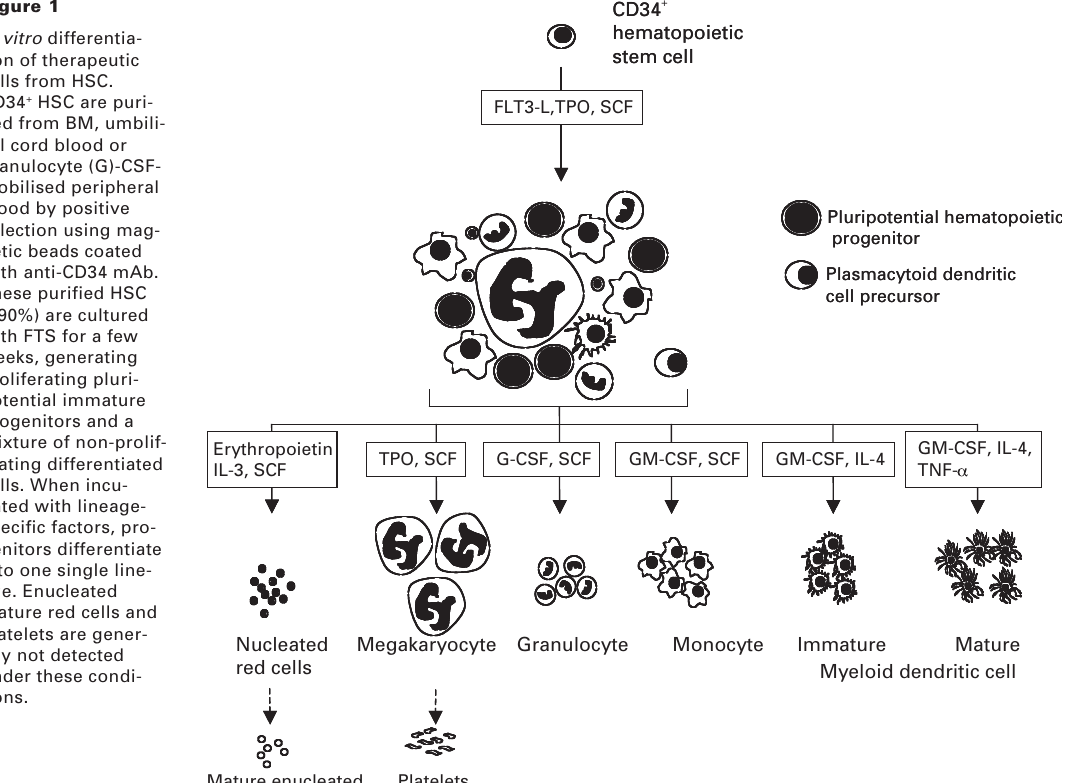
In vitrodifferentia- tion of therapeutic cells from HSC. CD34 + HSC are puri- fied from BM, umbili- cal cord blood or granulocyte (G)-CSF- mobilised peripheral blood by positive selection using mag- netic beads coated with anti-CD34 mAb. These purified HSC (>90%) are cultured with FTS for a few weeks, generating proliferating pluri- potential immature progenitors and a mixture of non-prolif- erating differentiated cells. When incu- bated with lineage- specific factors, pro- genitors differentiate into one single line- age. Enucleated mature red cells and platelets are gener- ally not detected under these condi-